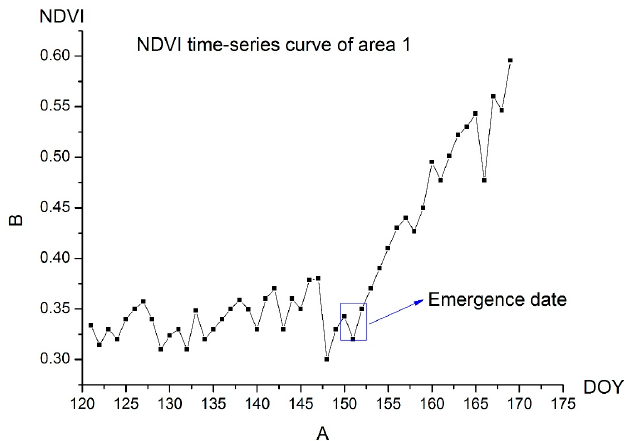
Figure 3. NDVI time-series curve of Area 1 in 2015.